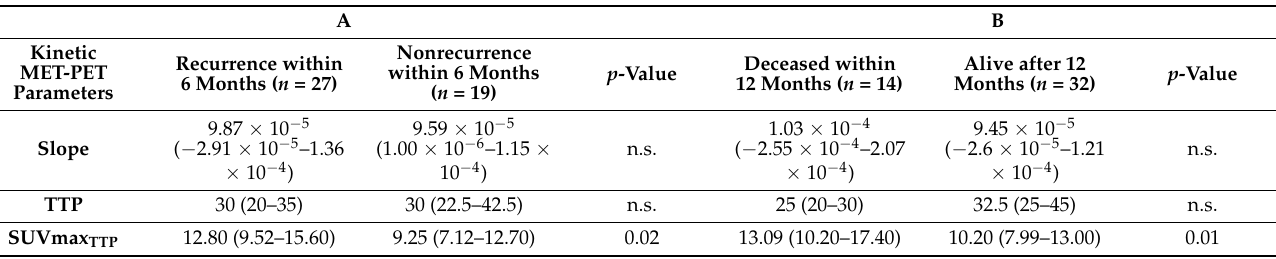
( p = 0.02). Table 5. Comparison of kinetic MET-PET parameters (A) between patients with and without recurrence within 6 months from MET-PET; (B) between patients deceased and alive within 1 year from MET-PET scan.